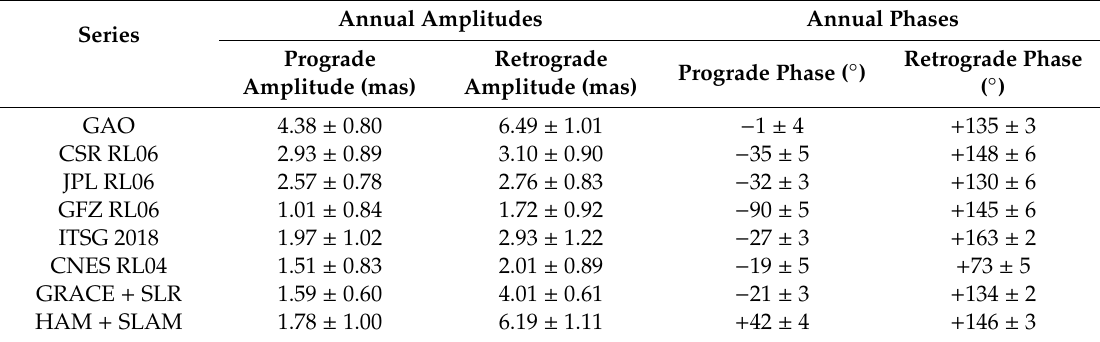
Table A2. Amplitudes and phases of prograde and retrograde annual oscillations of GAO, GSM, and HAM + SLAM together with their errors. The phases refer to the reference epoch starting on 1 January 2004.